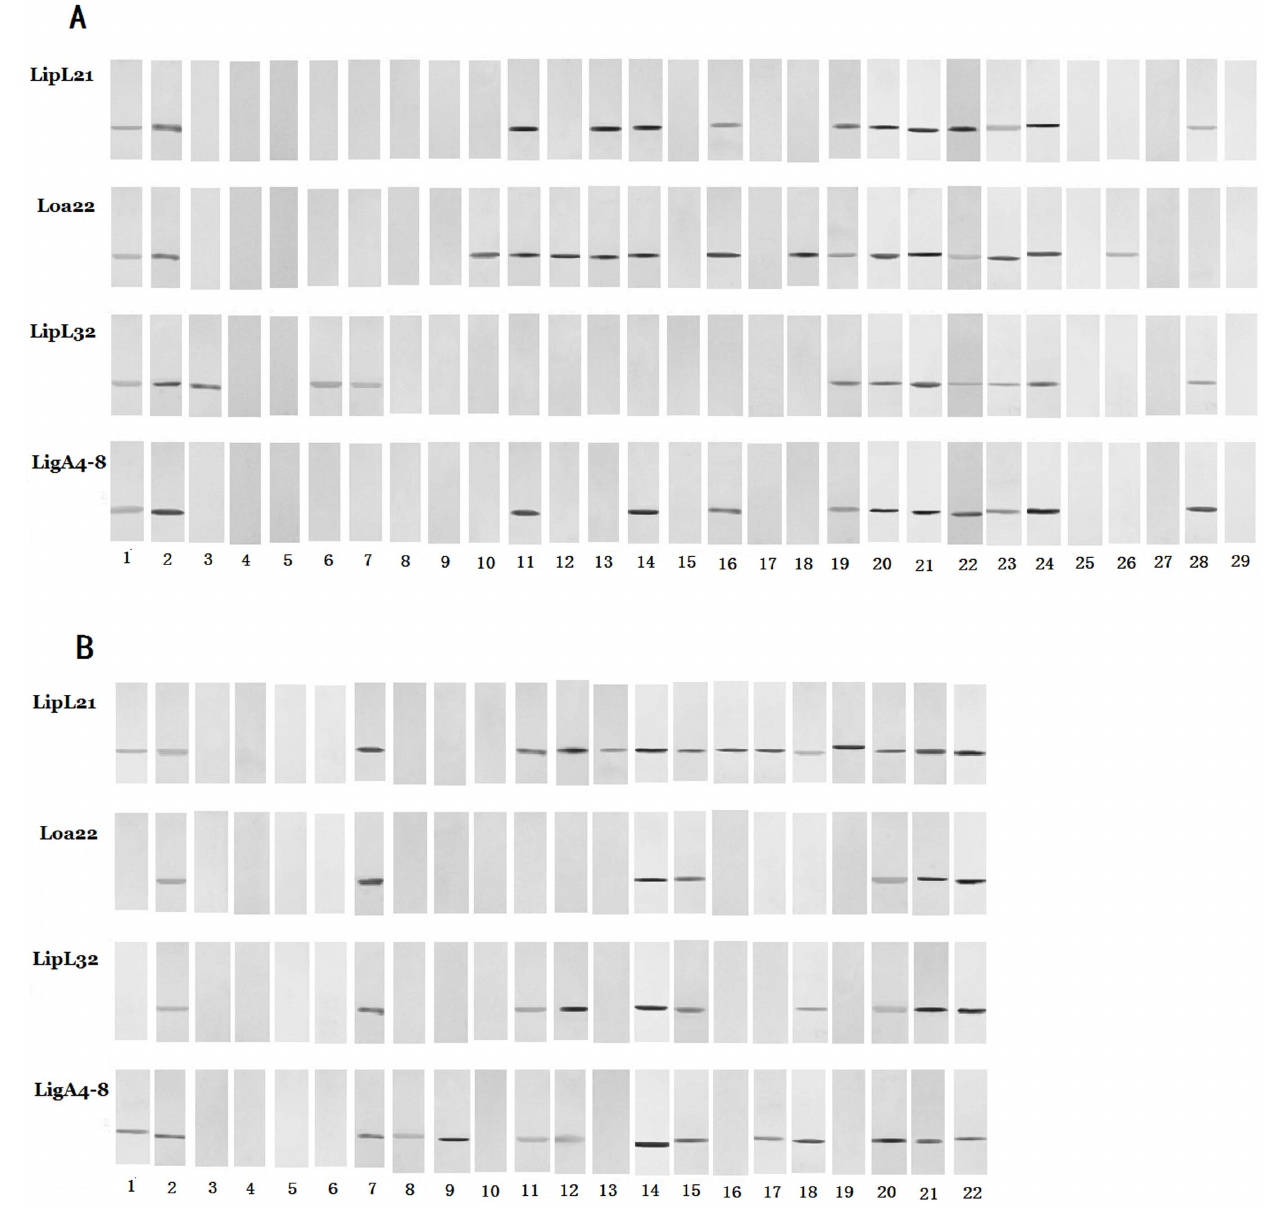
Fig. 2. Western blot analysis of canine serum. Sera that were MAT negative but ELISA positive (A) and MAT positive, but ELISA negative (B) were further tested by Western blotting. Purified recombinant proteins rLipL21, rLoa22, rLipL32 and rLigACon4-8 of L. interrogans were transferred from the SDS-PAGE separation gel to a nitrocellulose membrane. After washing with TBS, the membranes were blocked and then subjected to assay using the serum to be tested as the primary antibody and l:3,000-diluted, alkaline phosphatase-labeled goat anti-dog IgG (KPL, Inc., MD) as the secondary antibody. After this,